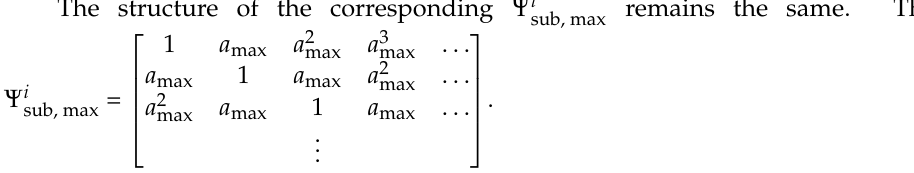
Figure 2. Variations of maximum a ι 1, (cid:96) q as a function of θ ( (cid:96) ) ; time interval = q ∆ t ; ∆ t = 1 s. The structure of the corresponding Ψ i